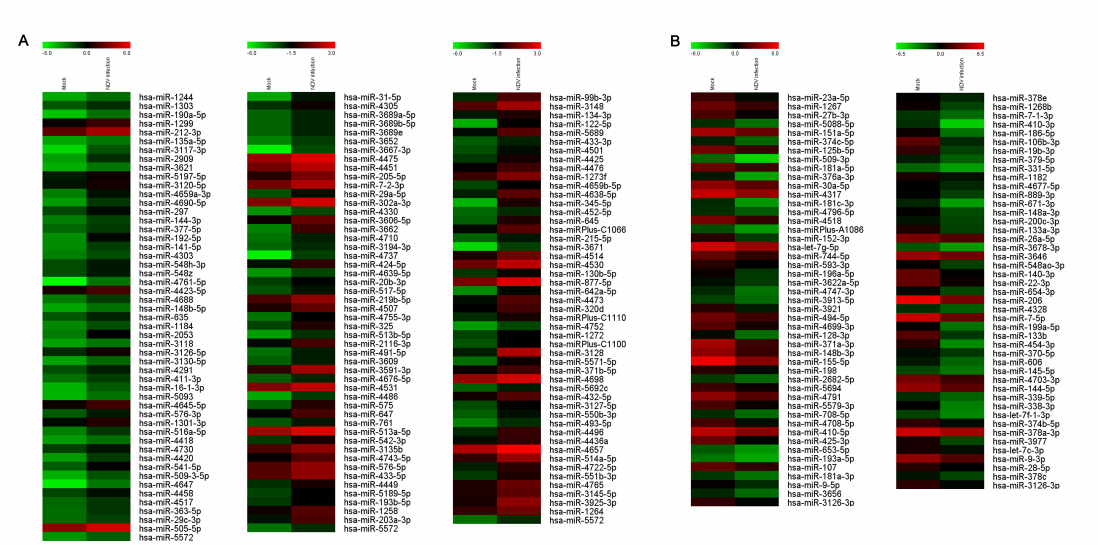
Figure 3. NDV infection alters host miRNAs expression in exosomes derived from HeLa cells. ( A ) Heat maps show miRNA expression that was upregulated more than 1.5-fold in exosomes derived from HeLa cells 24 h after NDV infection. ( B ) Heat maps show miRNA expression that was downregulated more than 1.5-fold in exosomes derived from HeLa cells 24 h after NDV